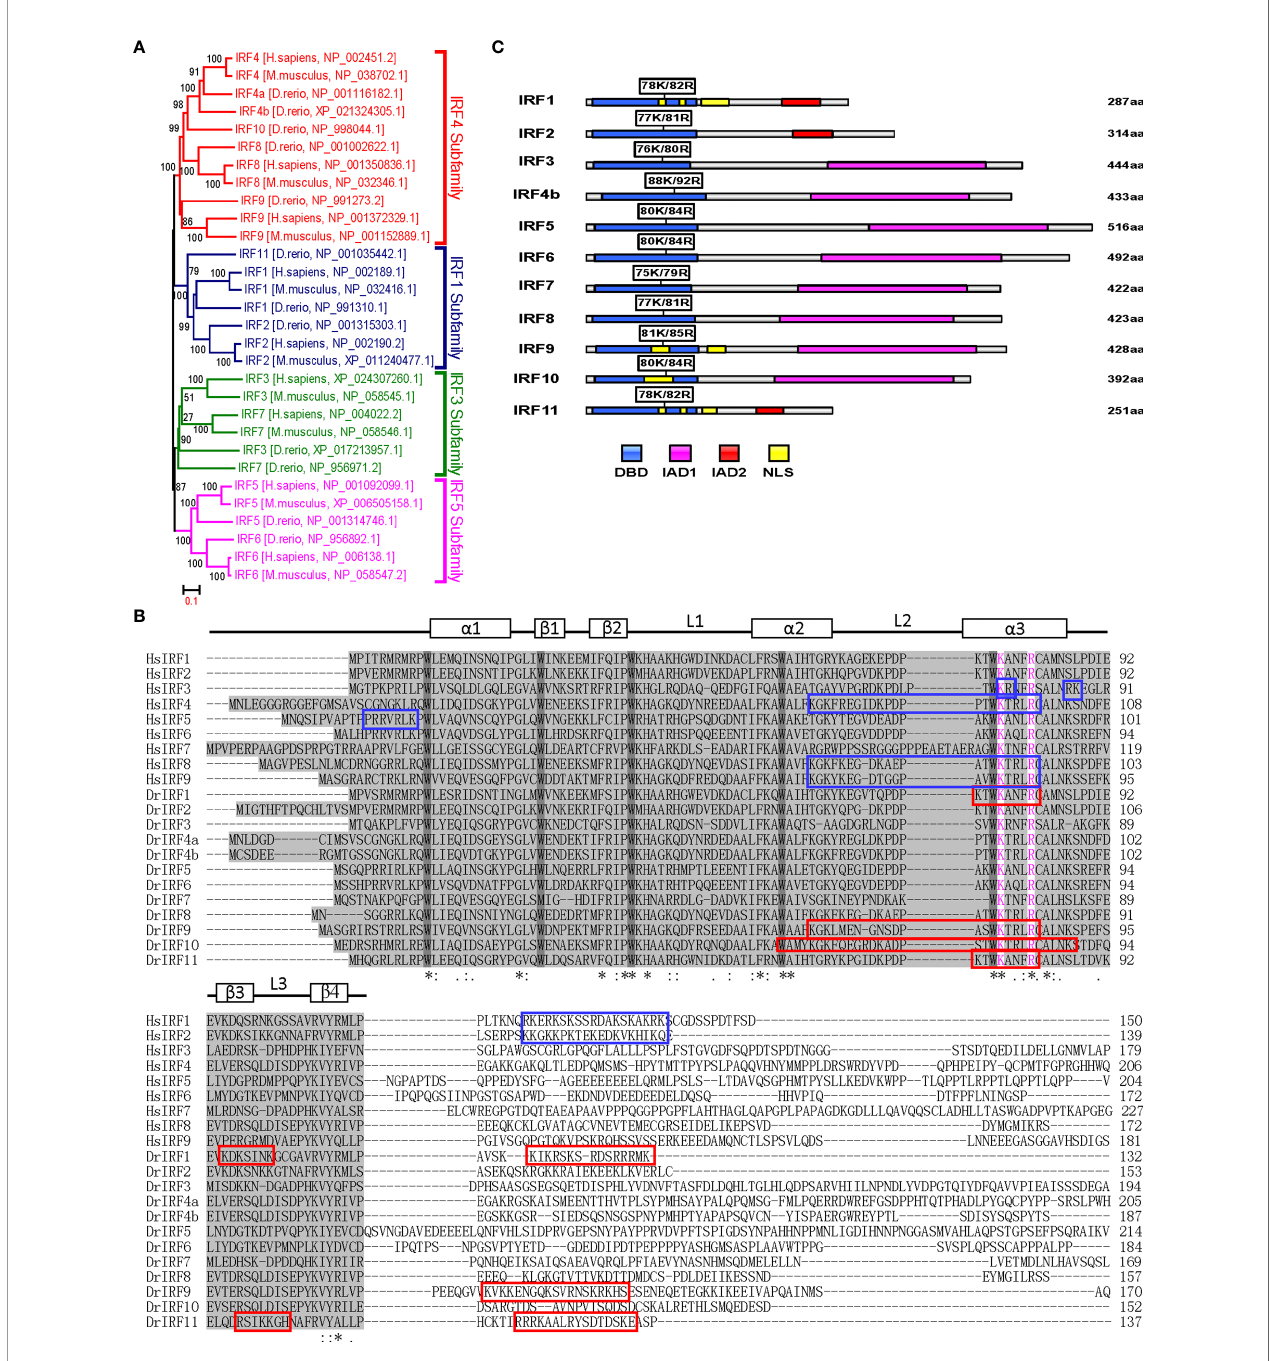
FIGURE 5 | K78 and R82 of a 3 helices in DBD domain of IRF11 are conserved across IRF family members. (A) Phylogenetic tree analysis of zebra fi sh and human IRF family members showing four IRF subfamilies. The phylogenetic tree was constructed by a neighbor-joining method in MEGA 5.0. The bootstrap con fi dence values shown at the nodes are based on 1000 bootstrap replications. (B) Multiple alignments of zebra fi sh IRF proteins showing a highly conserved DBD and the distribution of NLS motifs identi fi ed previously. DBD domains are gray with fi ve conserved tryptophans. The symbols, including a -helices, b -strands and loops, indicates the secondary structures of DBD, which are marked by rectangle and line. Based on publications, the identi fi ed NLS motifs of zebra fi sh IRF1/10/11 are indicated by red boxes, and the NLS motifs of human IRF1/2/3/4/5/8/9 in blue boxes. Zebra fi sh IRF11 has a tripartite NLS motif composed of NLS1, NLS2 and NLS3, with the conserved K78 and R82 that are highlighted in purple. Identical (*) and similar (: or.) amino acid residues are indicated. (C) Schematic diagram of zebra fi sh IRF proteins, showing the position of two conserved basic residues corresponding to K78 and R82 of zebra fi sh IRF11. All mutants of zebra fi sh IRF protein were generated by combined mutation of the corresponding two residues to